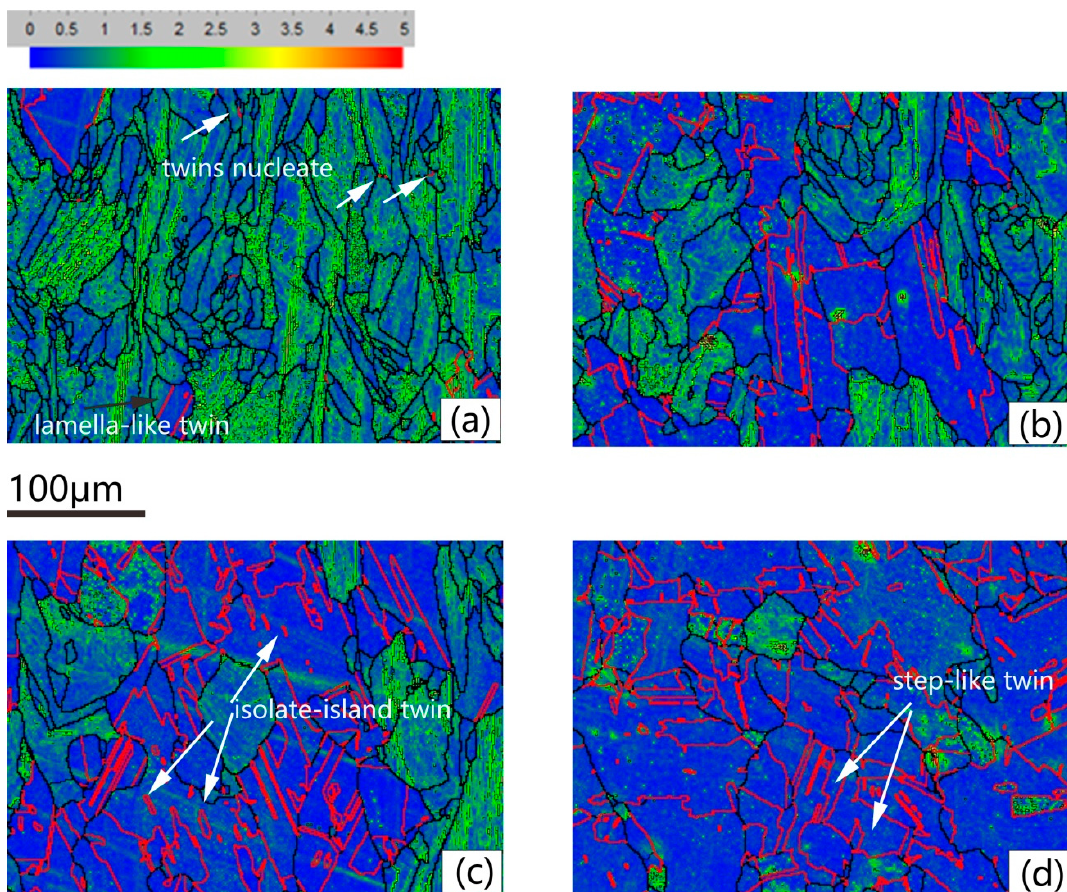
Figure 9. KAMAs distribution and <111> 60° annealing twins boundaries distribution under different conditions: ( a ) 1090 °C, ( b ) 1100 °C, ( c ) 1110 °C, ( d ) 1120 °C.